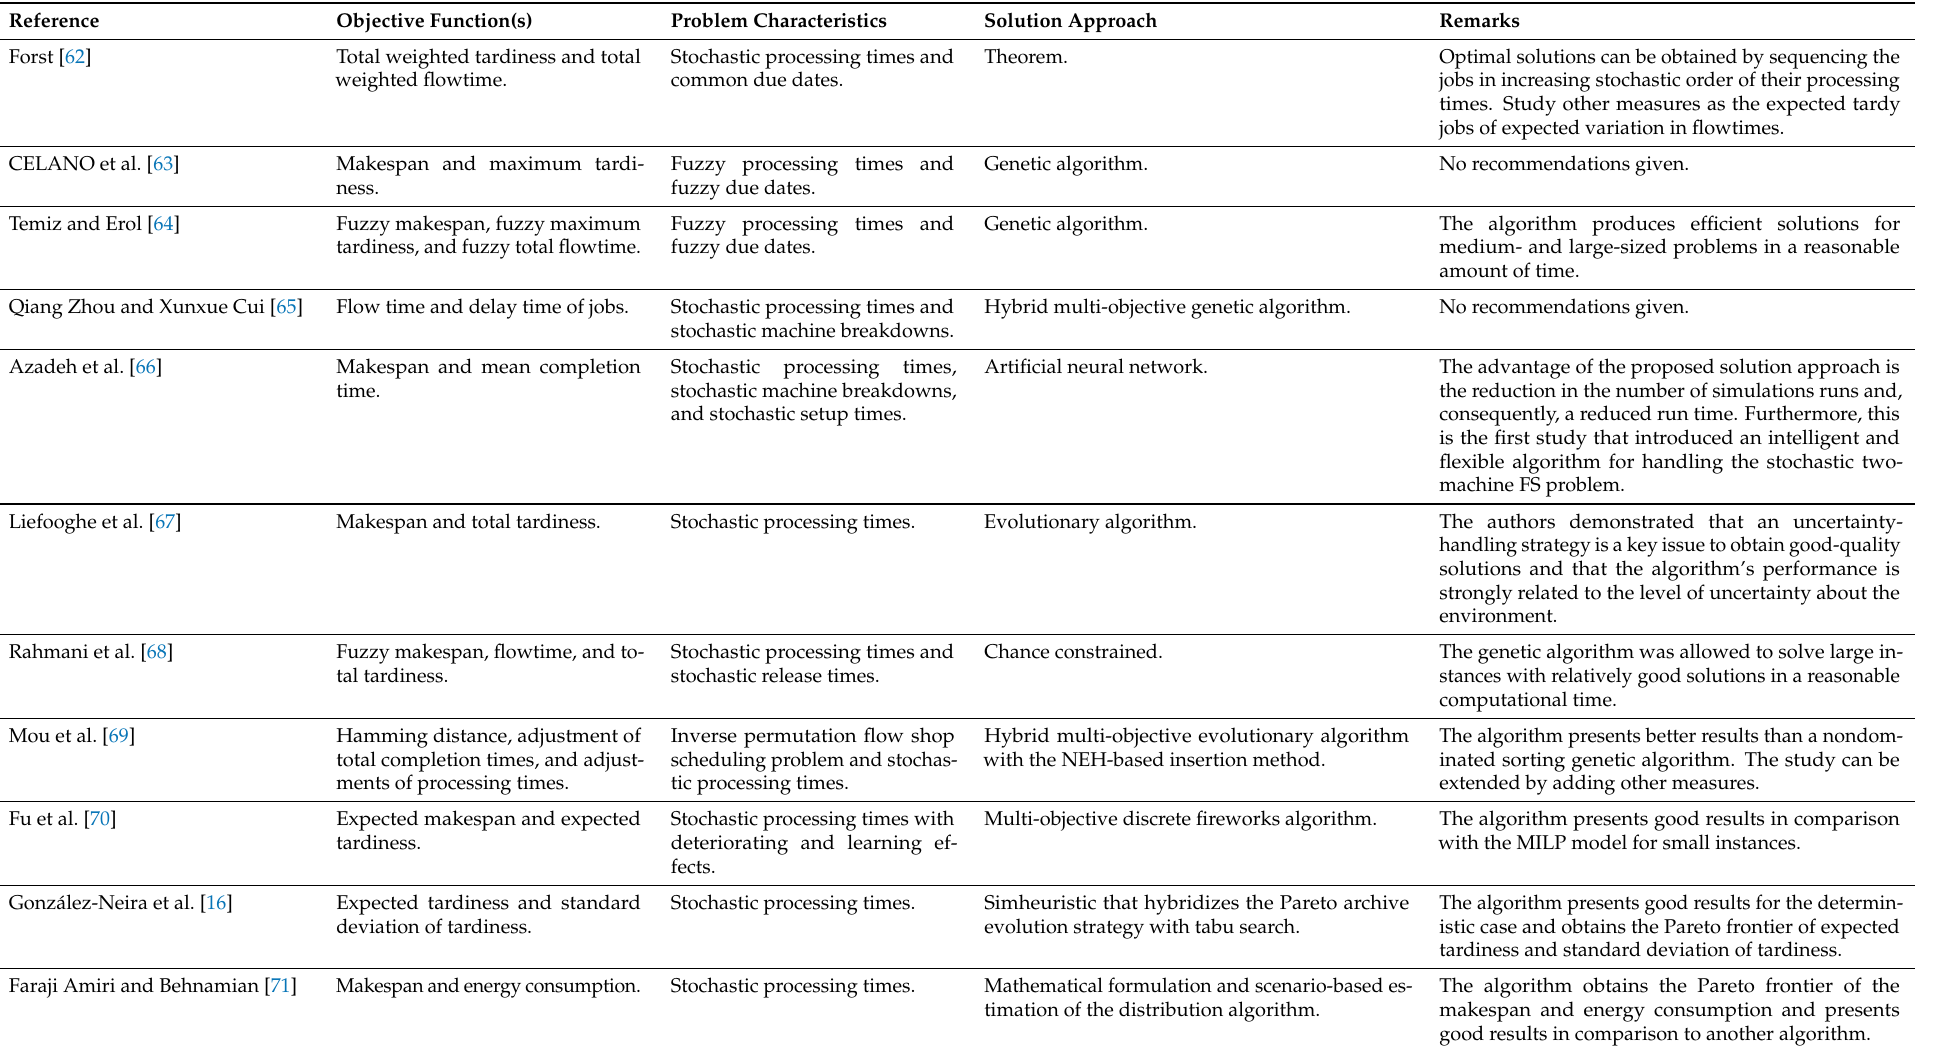
Table 2. Modeling approaches for the multi-objective stochastic flow shop problem